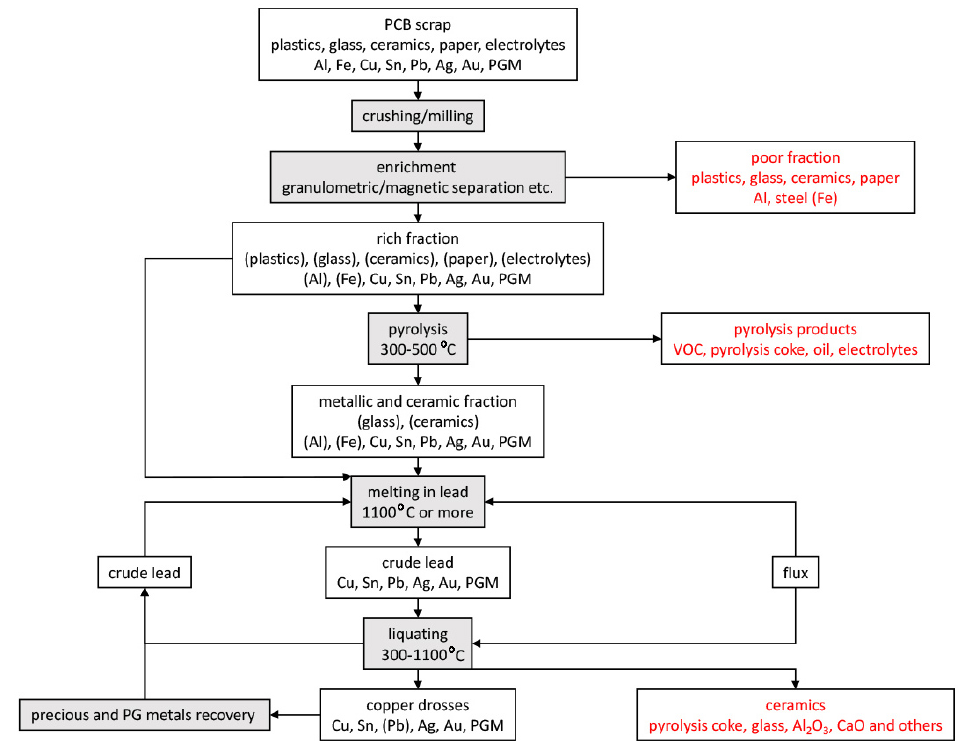
Figure 3. Scheme of non-ferrous metals recovery process from electrical/electronic scrap using lead melting and liquation .